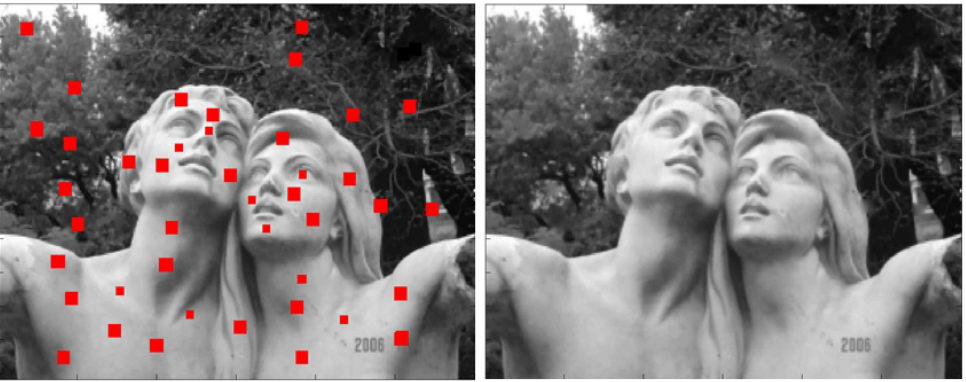
Figure 3. Damaged image restoration. Source: (Schönlieb 2012). Small red squares on the Figure 3 mark the damaged areas. On the right side, we can see the effect of the heat equation application. This characteristic of the heat equation was